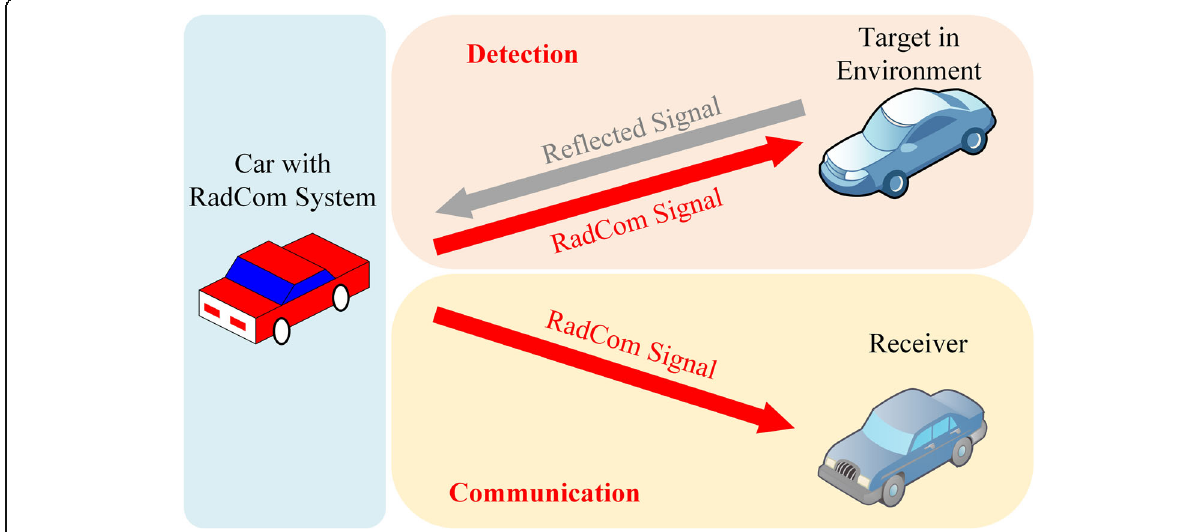
Fig. 1 RadCom system in vehicle networking